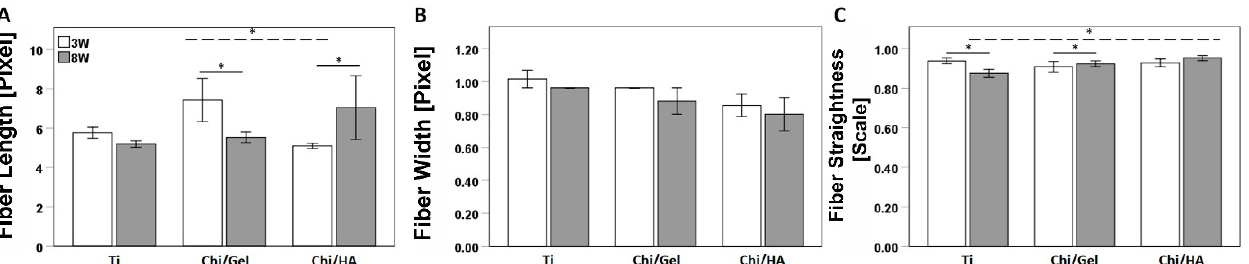
Figure 5. Enhanced collagen fiber properties led to enhanced micro-mechanical quality in Chi/Gel at 3 W and 8 W. CT-FIRE was used to quantify the collagen fibers from Sirius red-stained images. Collagen fibers orient mostly at smaller angles, <55 ◦ . ( A ) The fibers were mostly between 3 and 5 µ m in length, the Chi/Gel group showed longer fibers at the early time point and shorter at the later time point, the Chi/Ha showed an inverse pattern. ( B ) Fiber width reflects crosslinking and intramolecular spacing, all groups showed comparable width within the range of healthy tissue. ( C ) Fiber straightness indicates anisotropic nature of the matrix, at 8 W the Chi/Gel and Chi/HA show the highest values. (Ti: n = 5 (3 W), n = 3 (8 W); Gel: n = 5/time point; HA: n = 4 (3 W), n = 5 (8 W), *: p ≤